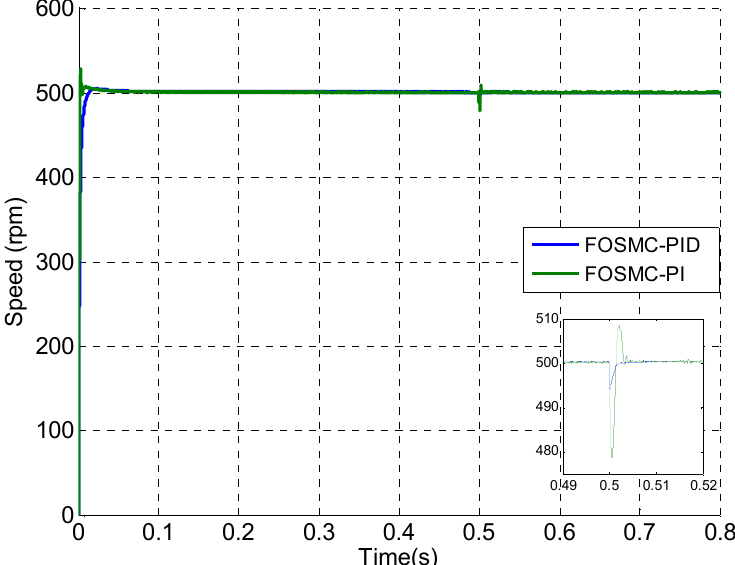
Figure 5. Speed response of FOSMC-PID and FOSMC-PI speed controller.